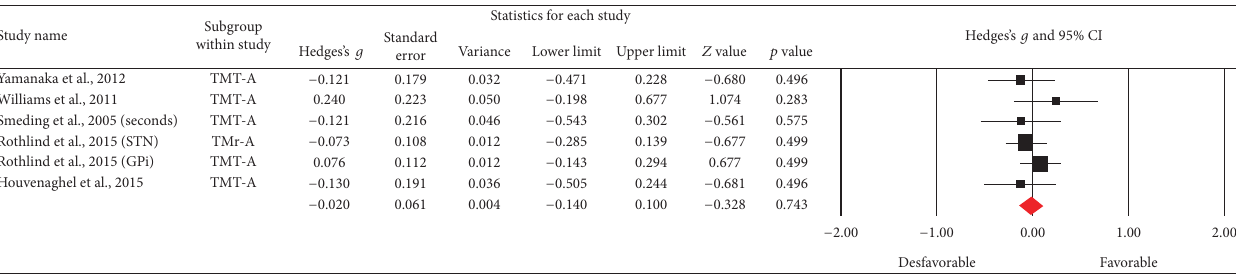
Figure 7: Meta-analysis of TMT-A comparing before and after DBS